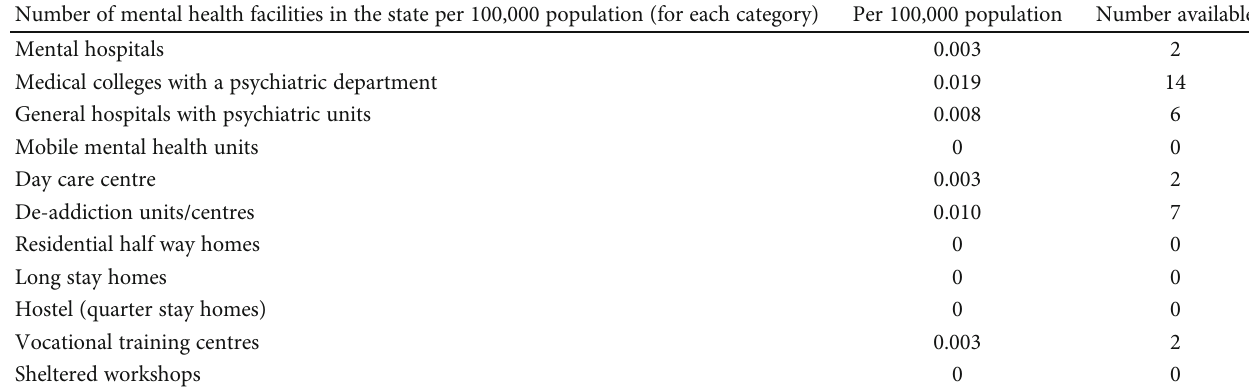
Table 2: Mental healthcare facilities in Madhya Pradesh (2015-16).